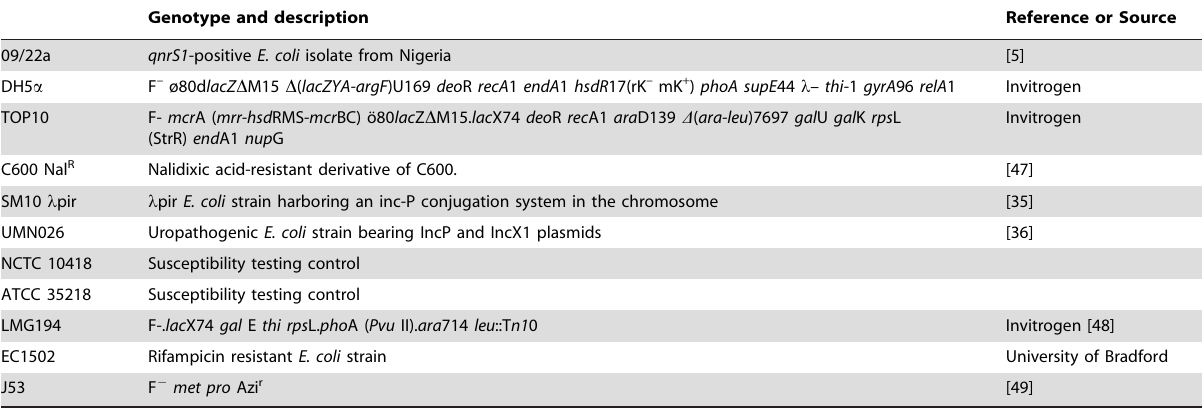
Table 1. Strains used in this